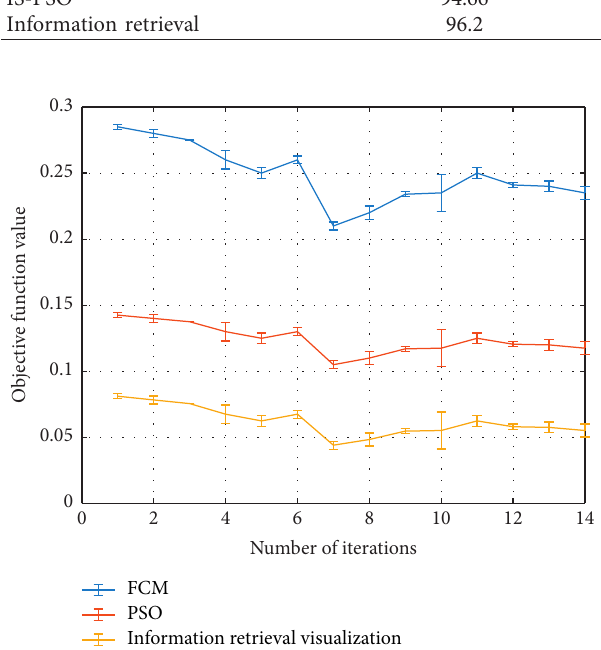
Figure 13: Simulation diagram of objective